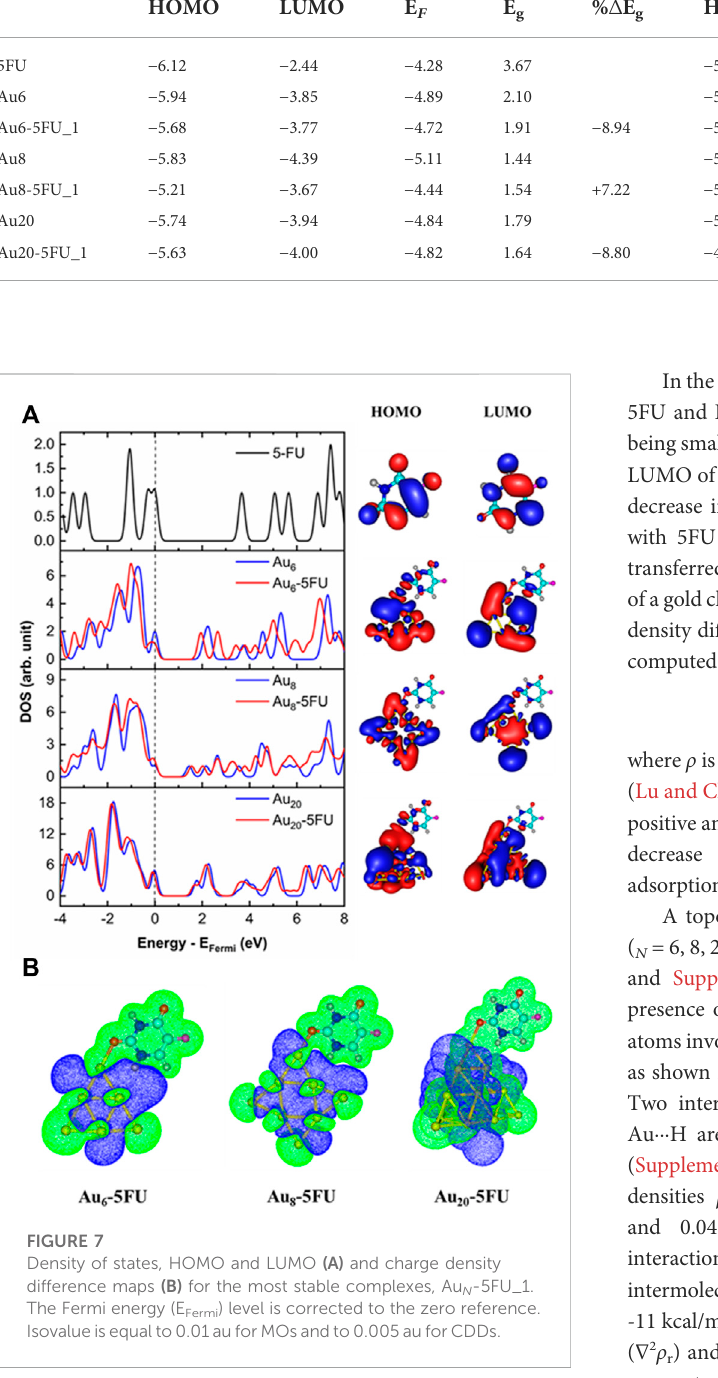
5FU molecule to the gold atoms, or reversedly depending on the energy gap between frontier states of adsorbent and adsorbate.